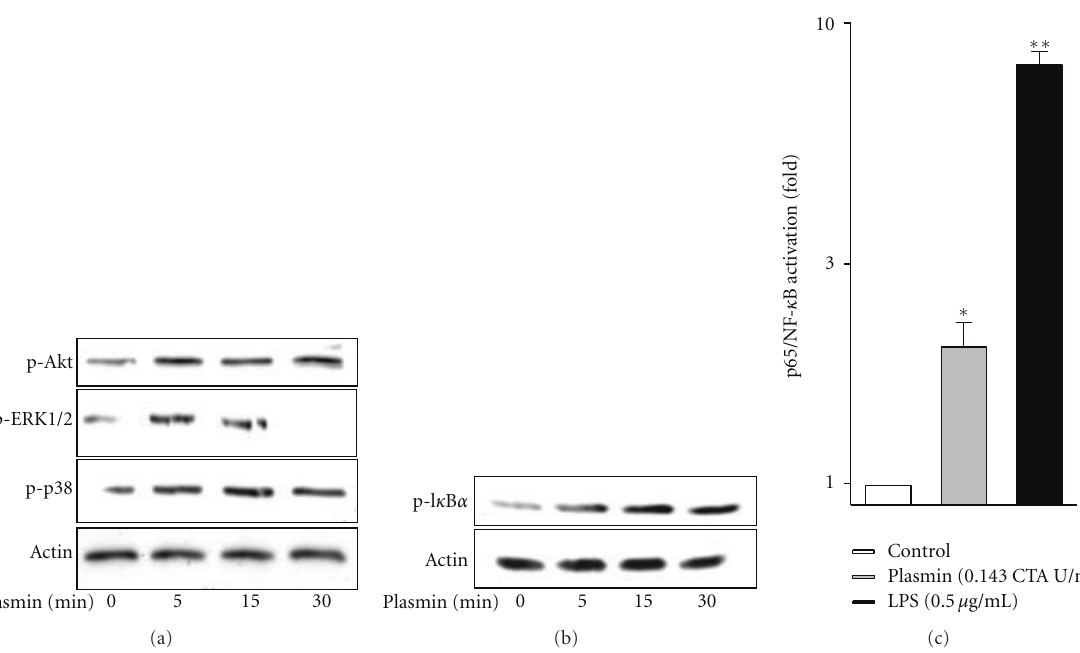
Figure 4: Plasmin activates Akt, MAPK, and NF- κ B signaling in dendritic cells. (a) Time-dependent phosphorylation of Akt (Ser473) and MAP kinases in dendritic cells after stimulation with plasmin (0.143 CTAU/mL). Dendritic cells were stimulated with plasmin, and whole cell lysates were analyzed by western immunoblotting; actin served as loading control. Representative data of three experiments are shown. (b) Time-dependent phosphorylation of I κ B α (Ser32/Ser36) in dendritic cells after stimulation with plasmin (0.143 CTAU/mL). Representative data of three experiments are shown. (c) Activation of p65 NF- κ B as analyzed with the NF- κ B TransAM ELISA. Nuclear extracts were obtained from dendritic cells stimulated with plasmin (0.143 CTAU/mL) or LPS (0.5 μ g/mL) for 1h. The results are mean ± SEM of 3 independent experiments, ∗ P < 0.05, ∗∗ P < 0.01 versus